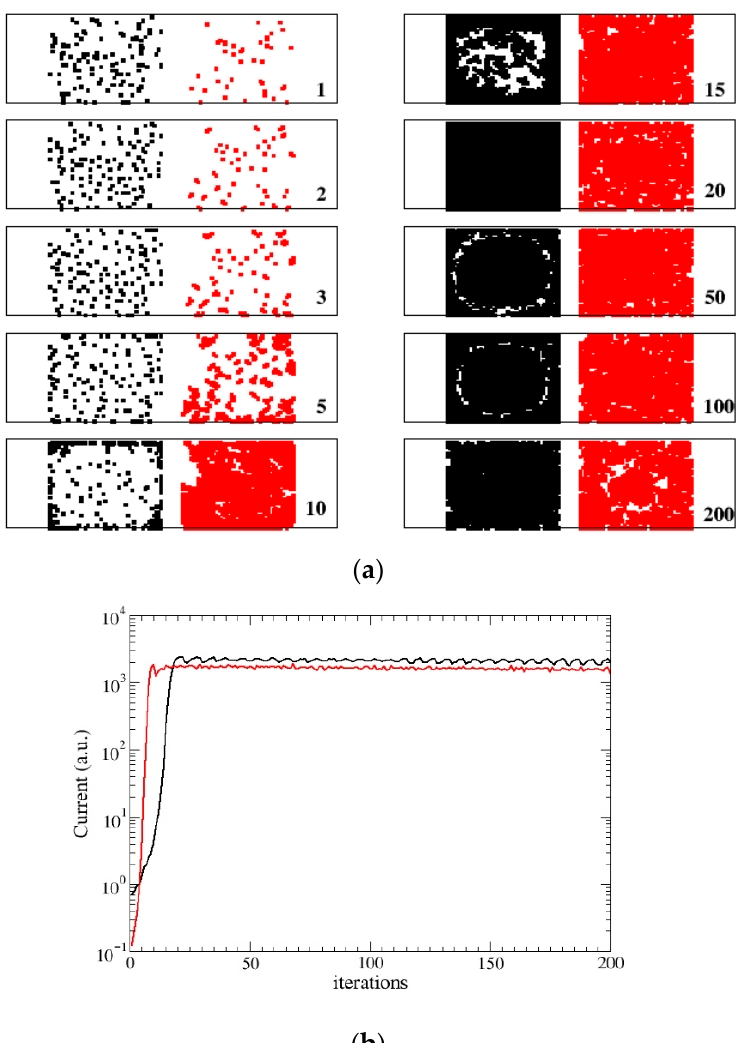
Figure 3. Colony formation in a 50 × 50 square lattice. Two different kinds of evolution are sketched. In black color: a quite large initial number of seeds (5% of total amount) with a small rate of reproduction ( σ = 22). In red color: a smaller initial number of seeds (1.5% of total amount) and a large rate of reproduction ( σ = 100). ( a ) Screenshots of colony formation taken at different evolution times from 1 to 200. ( b ) QS signal. The electrical current of the network reflects the QS for the development of a colony. The faster reproduction rate in the setup with a higher value of σ (red) with respect to that with a lower value of σ (black) is well reproduced.